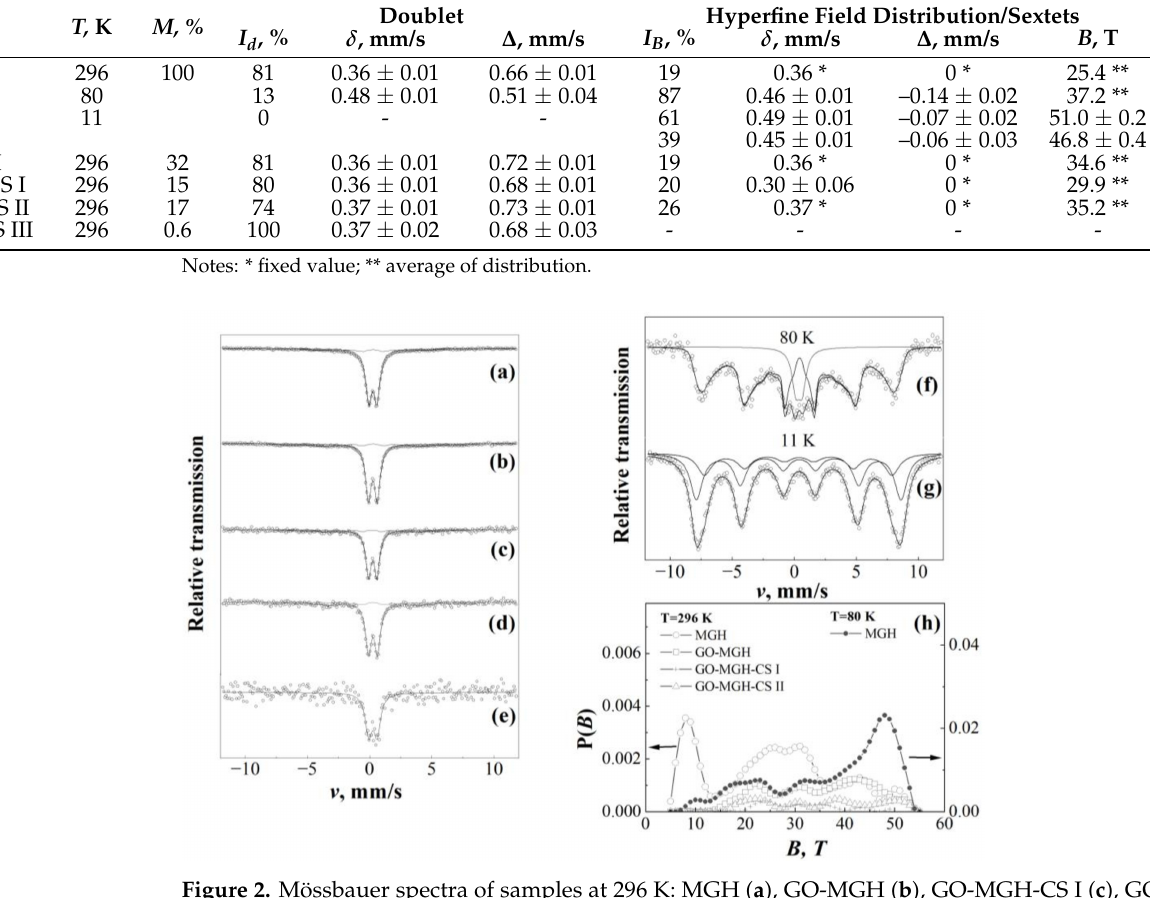
Figure 2. Mössbauer spectra of samples at 296 K: MGH ( a ), GO-MGH ( b ), GO-MGH-CS I ( c ), GO- MGH-CS II ( d ), GO-MGH-CS III ( e ), MGH at 80 K ( f ), and 11 K ( g ). The applied hyperfine field distributions are shown in ( h